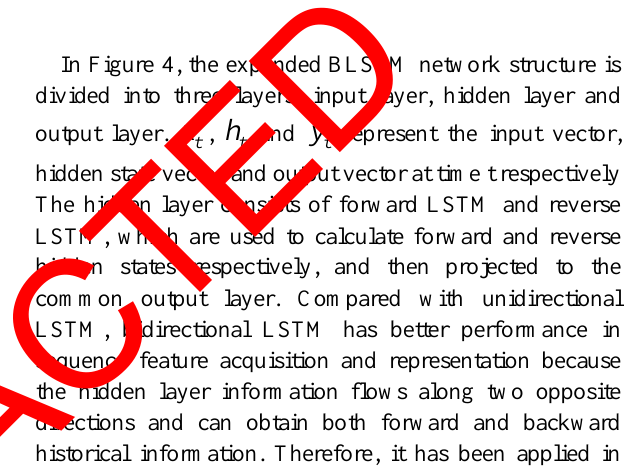
Figure 4. Unfolded BLSTM